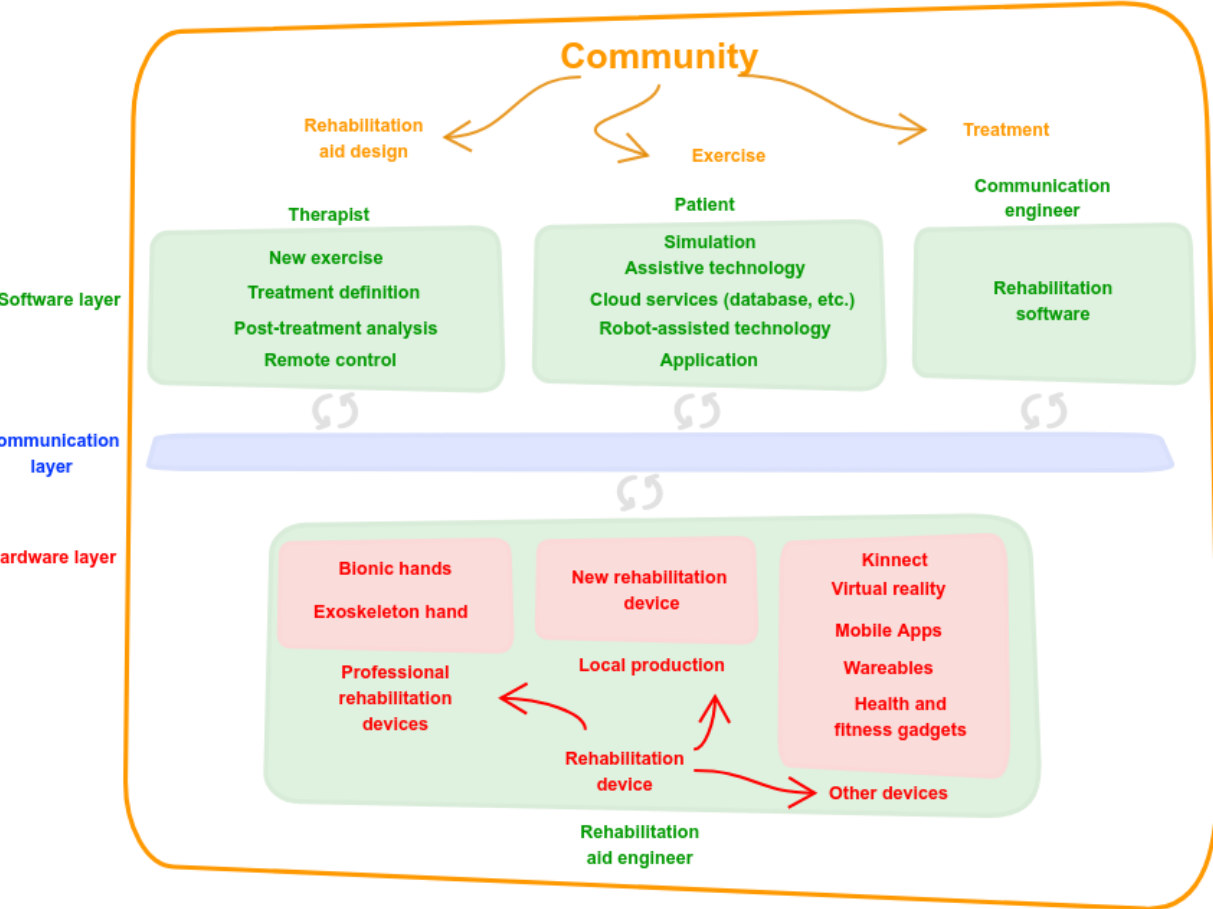
Figure 2. Extensive rehabilitation